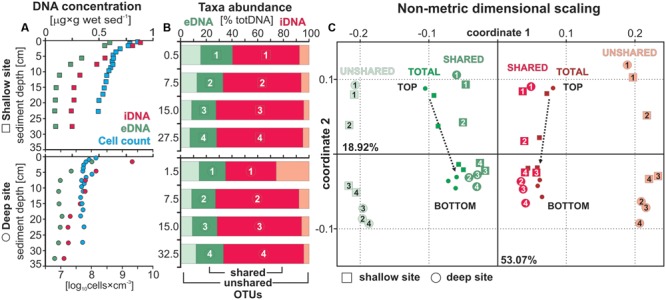
Extra- and intracellular DNA concentrations with total cell counts, taxa relative abundance and beta diversity. (A) DNA concentrations for the extracellular (green) and intracellular (red) fraction displayed in [μg × g wet sed-1] with total cell counts (blue) plotted in parallel [log10 cells × cm-3] for sediment samples at the shallow (squares) and deep (dots) site. (B) Relative abundances of OTUs shared (dark green, dark red) and unshared (light green, light red) by the extra- and intracellular DNA pools displayed in [% total DNA]. Each sample depth is denoted by a number and plotted as such in the following diagram. (C) Non-metrical dimensional scaling (NMDS) plotted for both sites emphasizing the distance between unshared eDNA and iDNA taxa. Samples related to the total eDNA and iDNA merge toward the center with sample depth as the likely result of extracellular DNA inputs due to cell lysis.